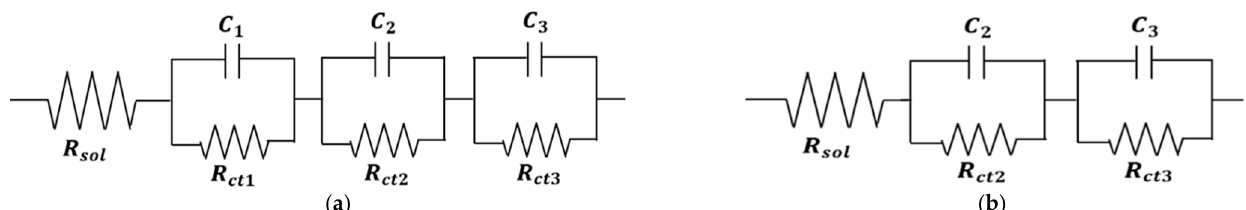
Figure 5. Nyquist plots of two types of electrodes.